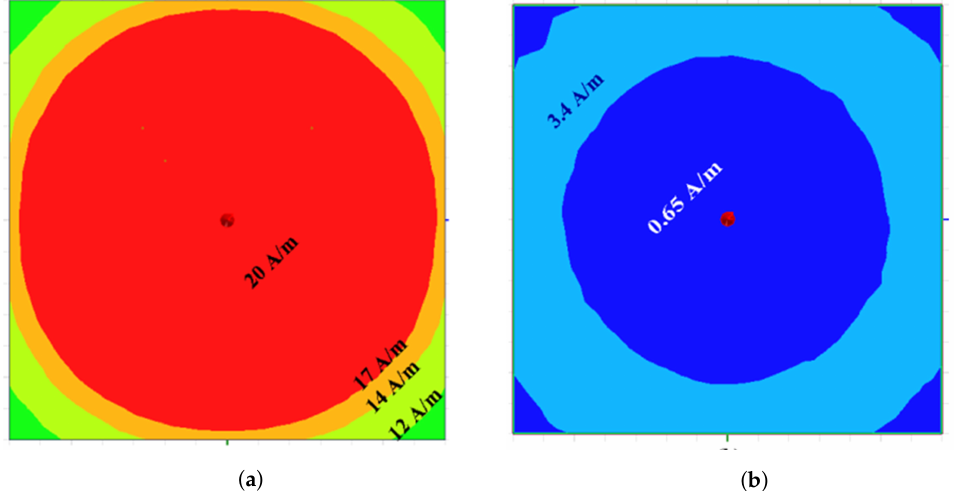
Figure 13. Magnetic field intensity (A/m), ( a ) two coils with ferrite core; ( b ) two coils with ferrite cores and Al plates.